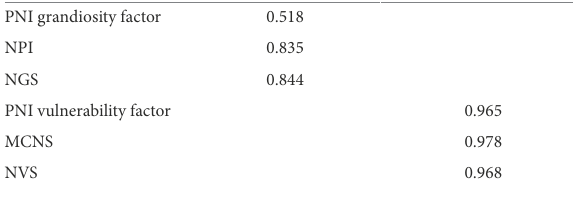
TABLE 3 Comparing the nomological networks of the PNI-S factors with intraclass correlation coefficients (ICC) in Sample 1.